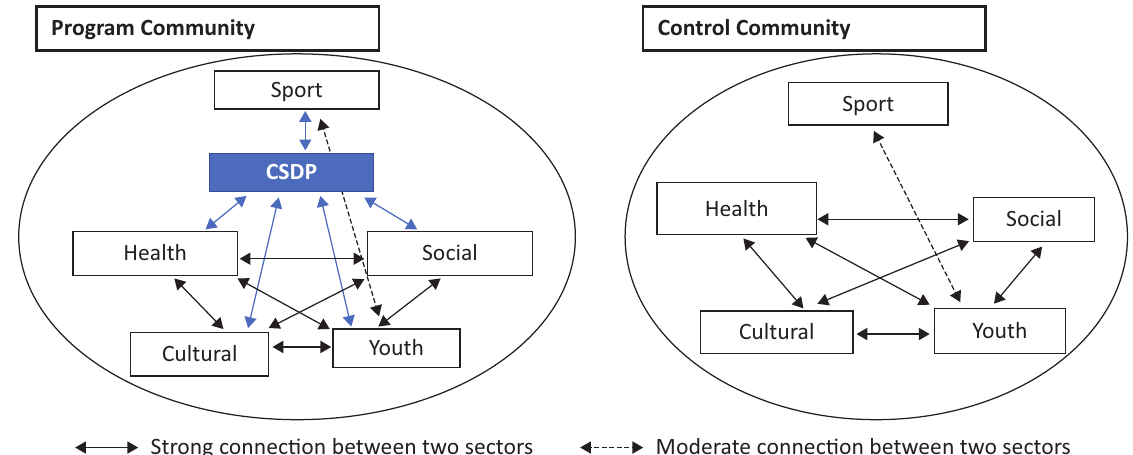
Figure 1. Graphical representation of the connections between sport, health, social, cultural and youth organizations in CSDP and control